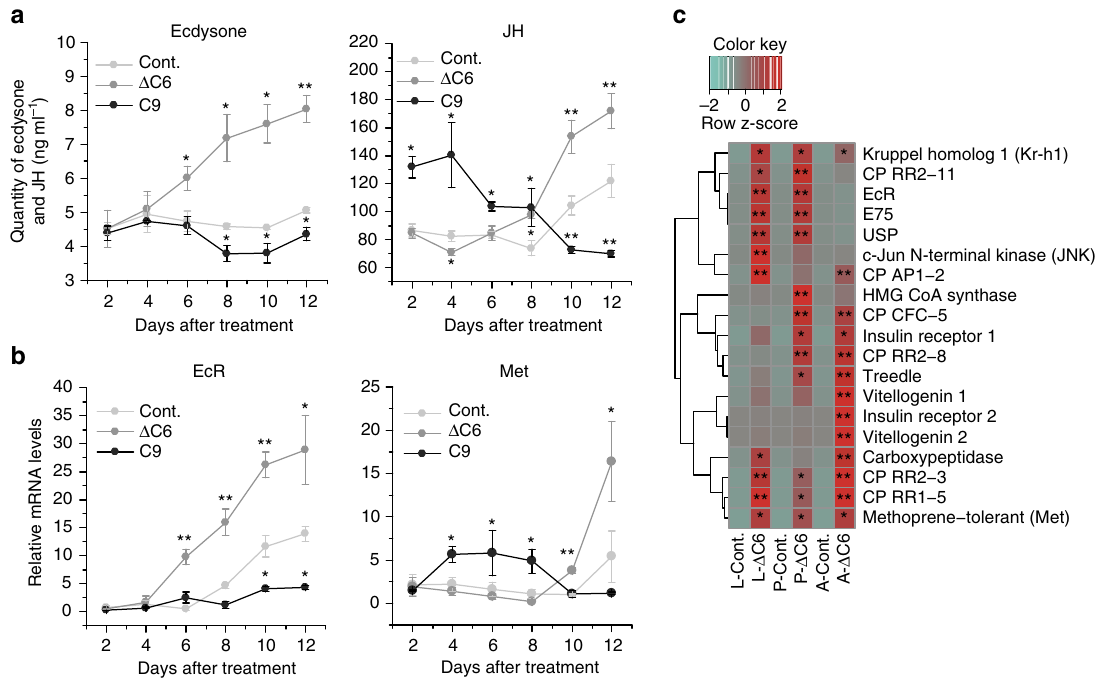
Figure 2 | Effects of ascarosides on hormone production and gene expression. ( a ) Effects of asc- D C6 and asc-C9 on ecdysone and JH production in fifth instar beetle larvae. Values are expressed as mean ± s.e.m. of three independent experiments. * P o 0.05 versus control and ** P o 0.01 versus control (Kruskal–Wallis nonparametric test, Mann–Whitney U test). ( b ) Effects of asc- D C6 and asc-C9 on gene expression of EcR and Met in fifth instar beetle larvae by qPCR. Values are expressed as mean ± s.e.m. of three independent experiments. * P o 0.05 versus control and ** P o 0.01 versus control (Student’s t -test, unpaired, two-tailed). ( c ) Hierarchical clustering of gene expression of gene cohorts related to autogeny, JH and ecdysone, and cuticle proteins in larvae, pupae and adults by qPCR ( n ¼ 3). L-Cont.: control larvae after 12 days; L- D C6: larvae after 12 days treatment with asc- D C6; P-Cont.: control pupae after 1 day; P- D C6: pupae after 1 day treatment with asc- D C6; A-Cont.: control adults after 1 day; A- D C6: adults after 1 day treatment by asc- D C6. Values are expressed